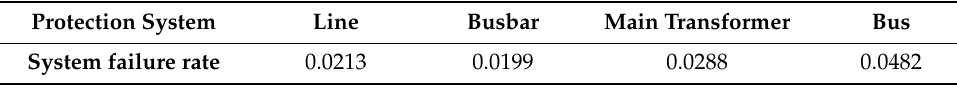
Table 7. Failure rate of protection system.